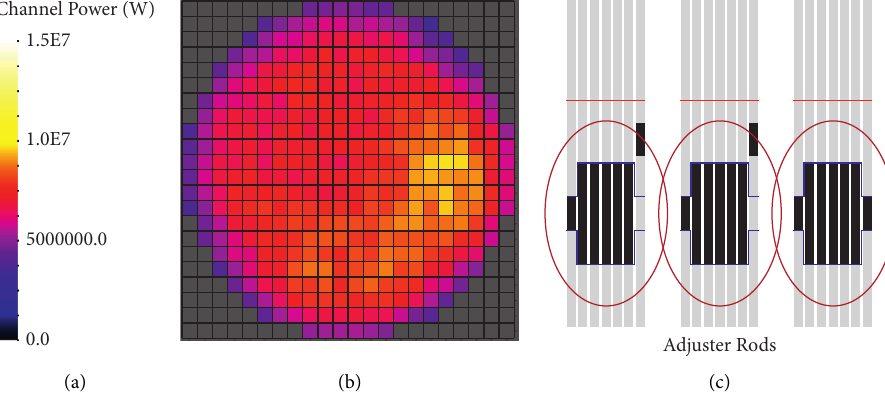
Figure 16: End state for adjuster rod withdrawal. Color legend provided by (a) for the power profile given by (b). Final adjuster rod positions for the transient given by (c), shown in three groups of 7 from front to back, with each group shown from left to